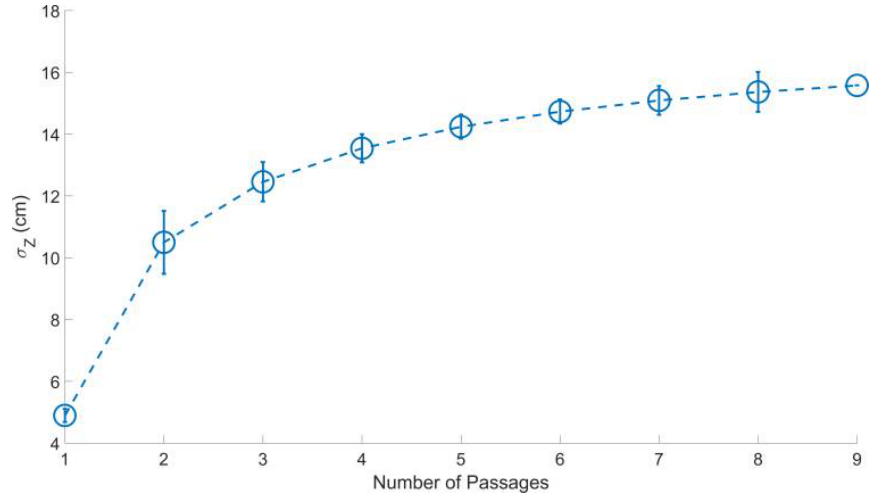
Figure 12. Uncertainty in Z as a function of number of passages over the target. Blue bars are the standard deviation of uncertainty.